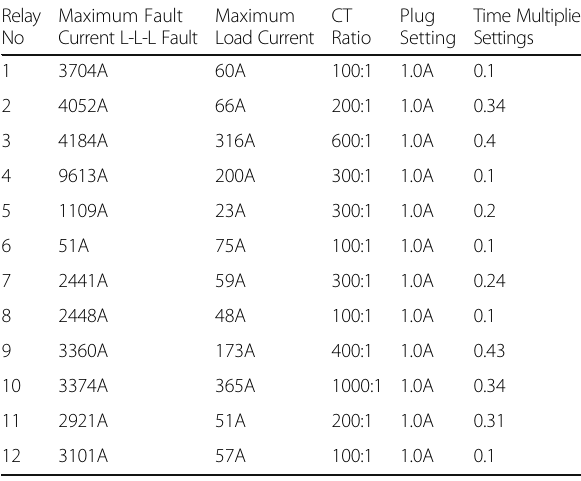
Maximum Load Current